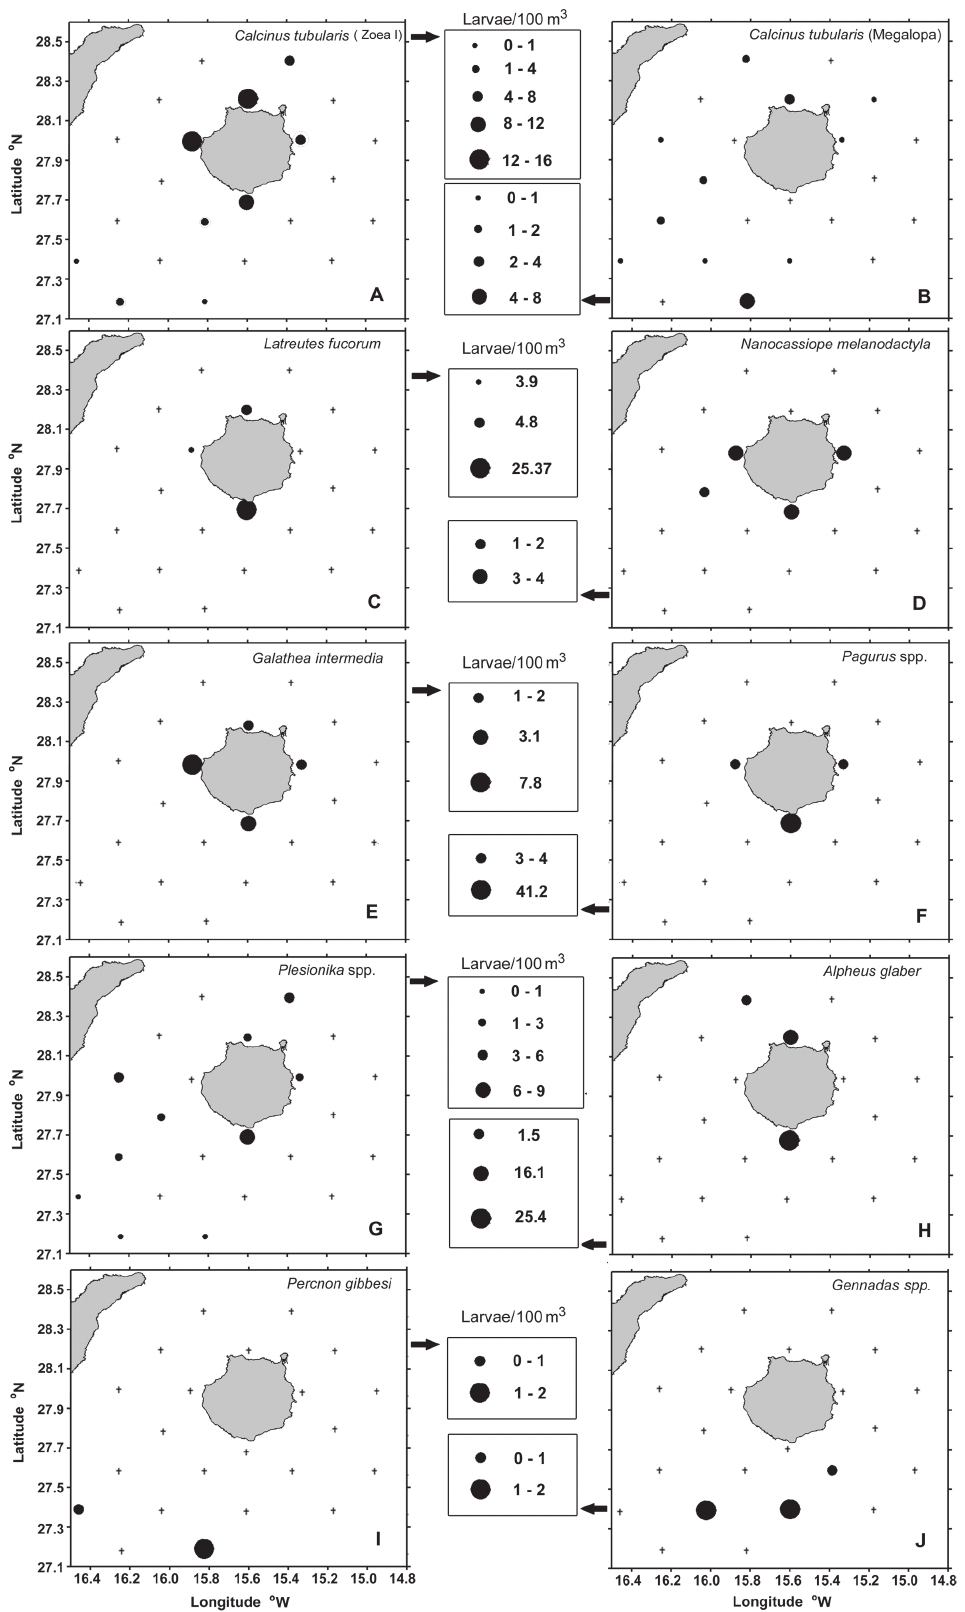
Fig . 5. – Horizontal distribution of the most representative decapod larvae (larvae/100 m 3 ). crosses refer to the sampled